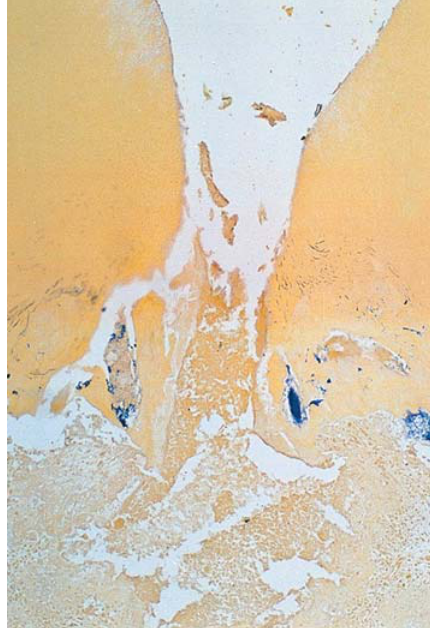
FIGURE 8a- Amplification of Figure 8. Bacilli and gram- positive filaments, Brown & Brenn -